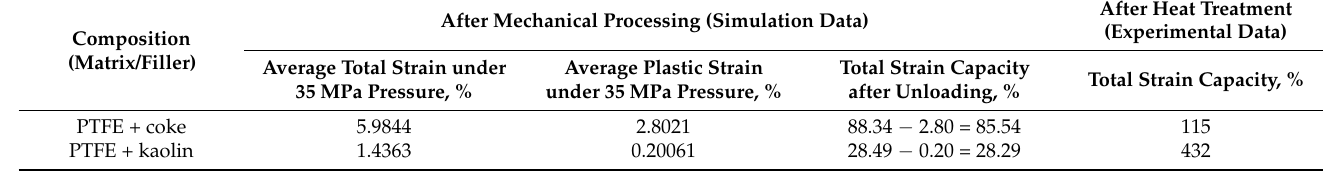
Table 3. Strain capacity of composite materials after mechanical processing based on simulations and experimental data for materials after heat